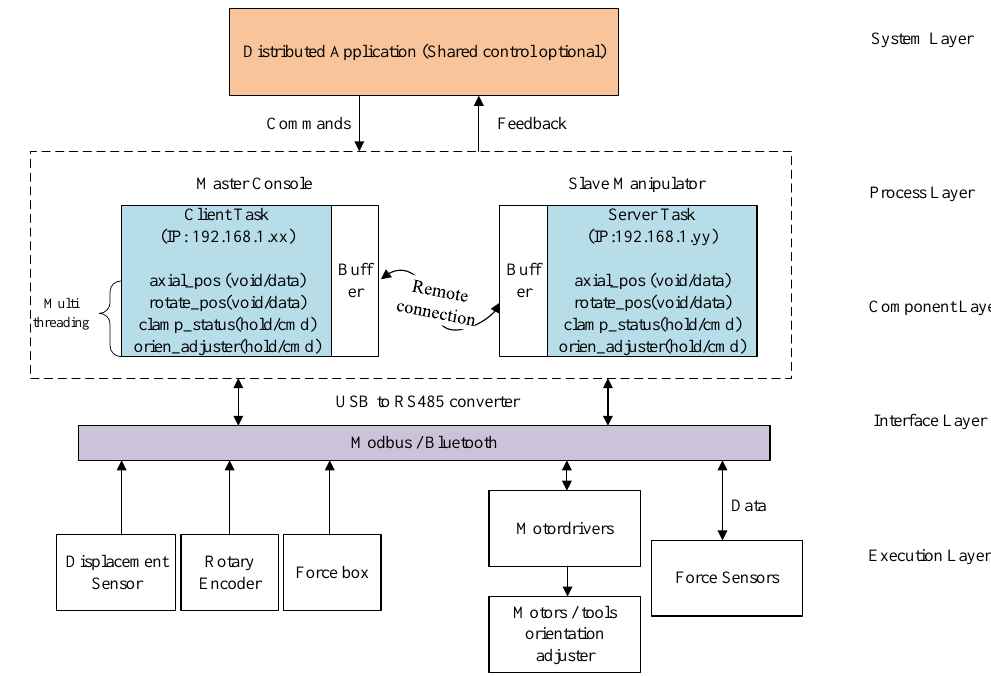
Figure 2. Layers of the VISR control